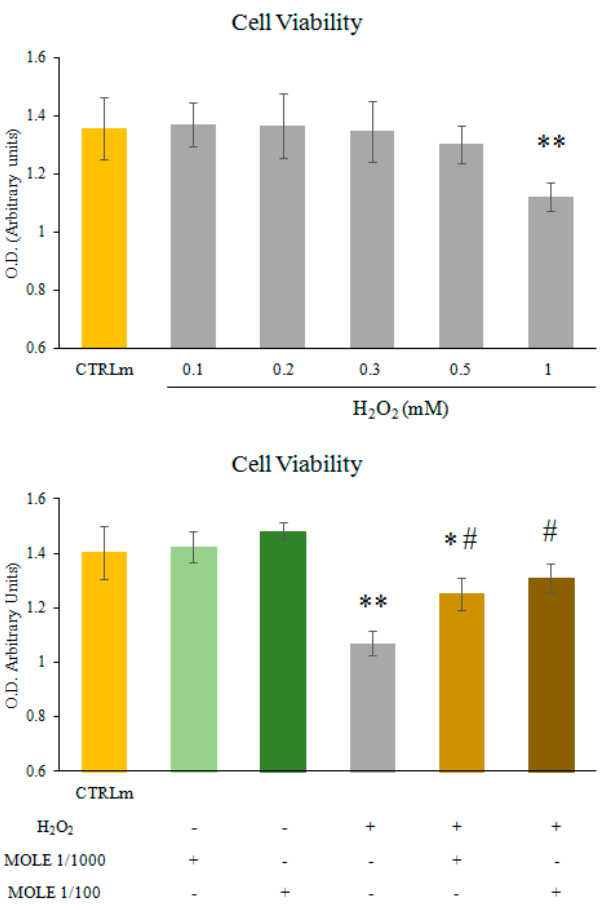
Figure 2. MTT assay. C2C12 myotubes were treated with different H 2 O 2 concentrations (0.1–1 mM) for 1 h (dose-dependence, upper panel). Then the effects of MOLE pre-treatments were assayed. C2C12 myotubes were treated with MOLE stock solution dilutions (1/1000 and 1/100 working solution) or vehicle (methanol) in culture media for 24 h. Then, hydrogen peroxide (1 mM) was added to samples pre-treated with vehicle or MOLE for a further hour (lower panel). Cell viability was assessed by the MTT assay. Data presented are the mean ± S.D. of three experiments, each performed in triplicate. * p < 0.05; ** p < 0.01 vs. CTRLm; # p < 0.05 vs. H 2 O 2